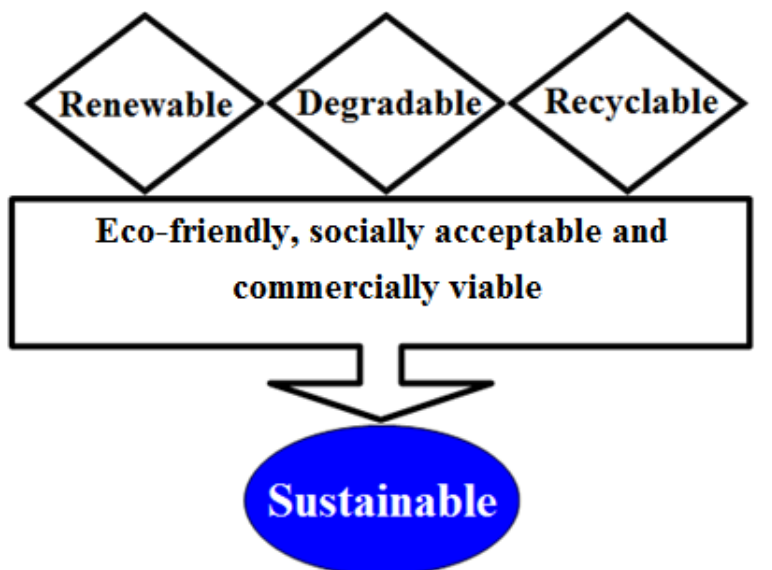
Figure 1. Concept of “sustainability”. Adapted with permission from Iqbal, [7].